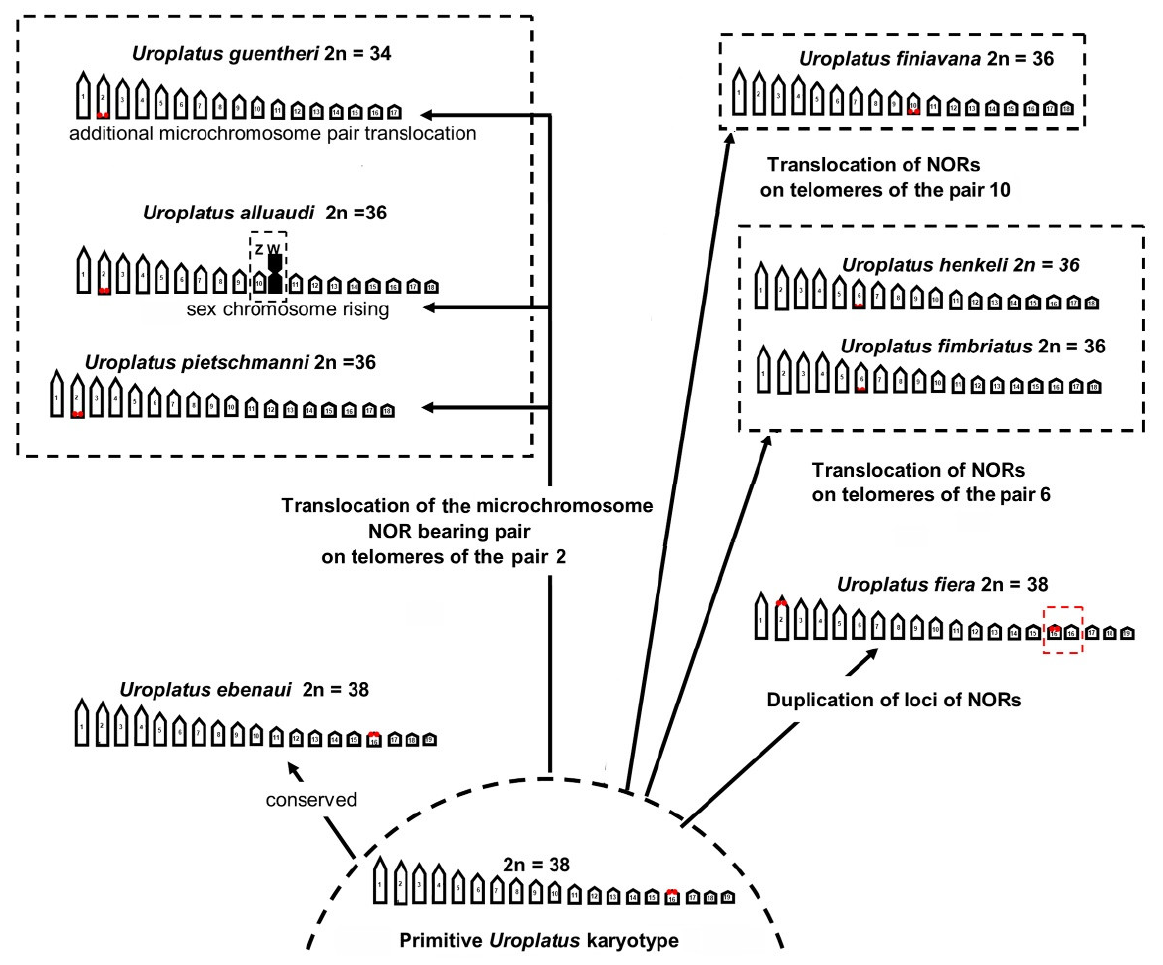
Figure 4. Hypothesized scenario of chromosome diversification in Uroplatus .